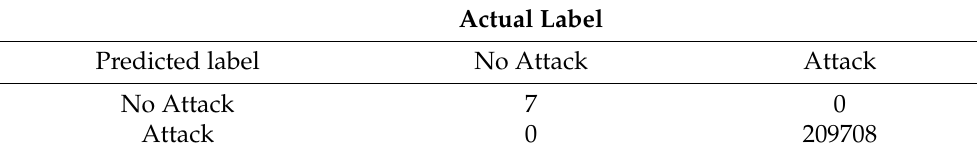
Table 19. DDoS UDP KNN confusion matrix.